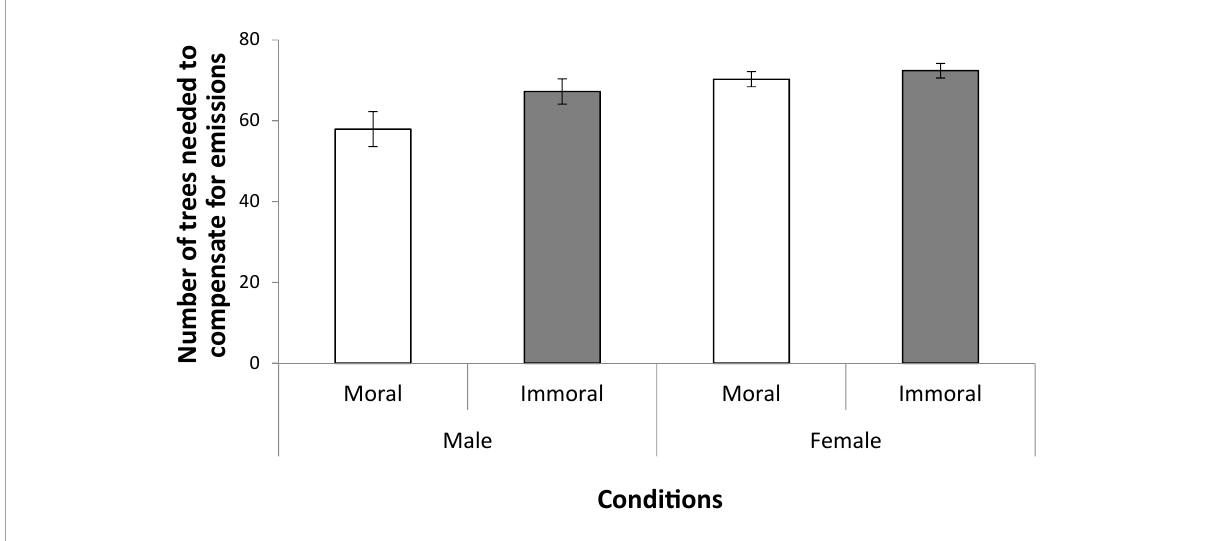
FIGURE1 Mean estimates of how many trees needed to compensate for the emissions of an airplane trip made for either a moral or an immoral reason. Gender and moral reason main effects were significant, with no significant interactions. Error bars represent the standard error of the mean.